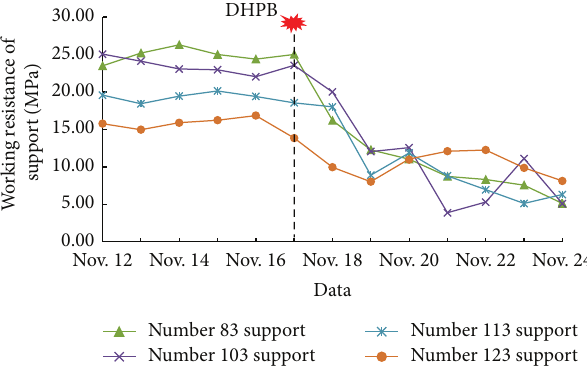
Figure 7: Working resistance variation of hydraulic supports before and after